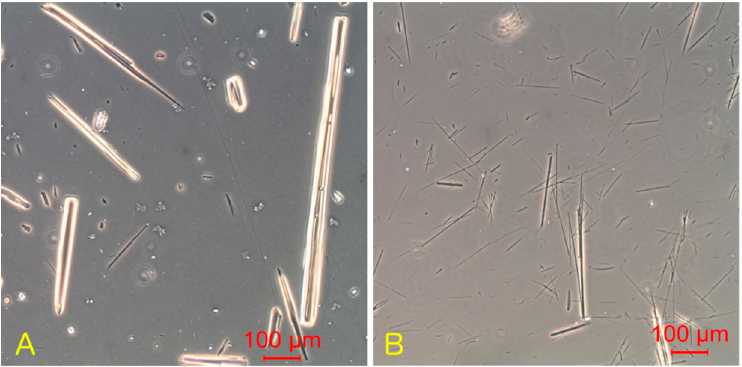
Figure 5. Examples of field crowding for counting and measuring elements: ( A ) Readable field, ( B ) crowded field.